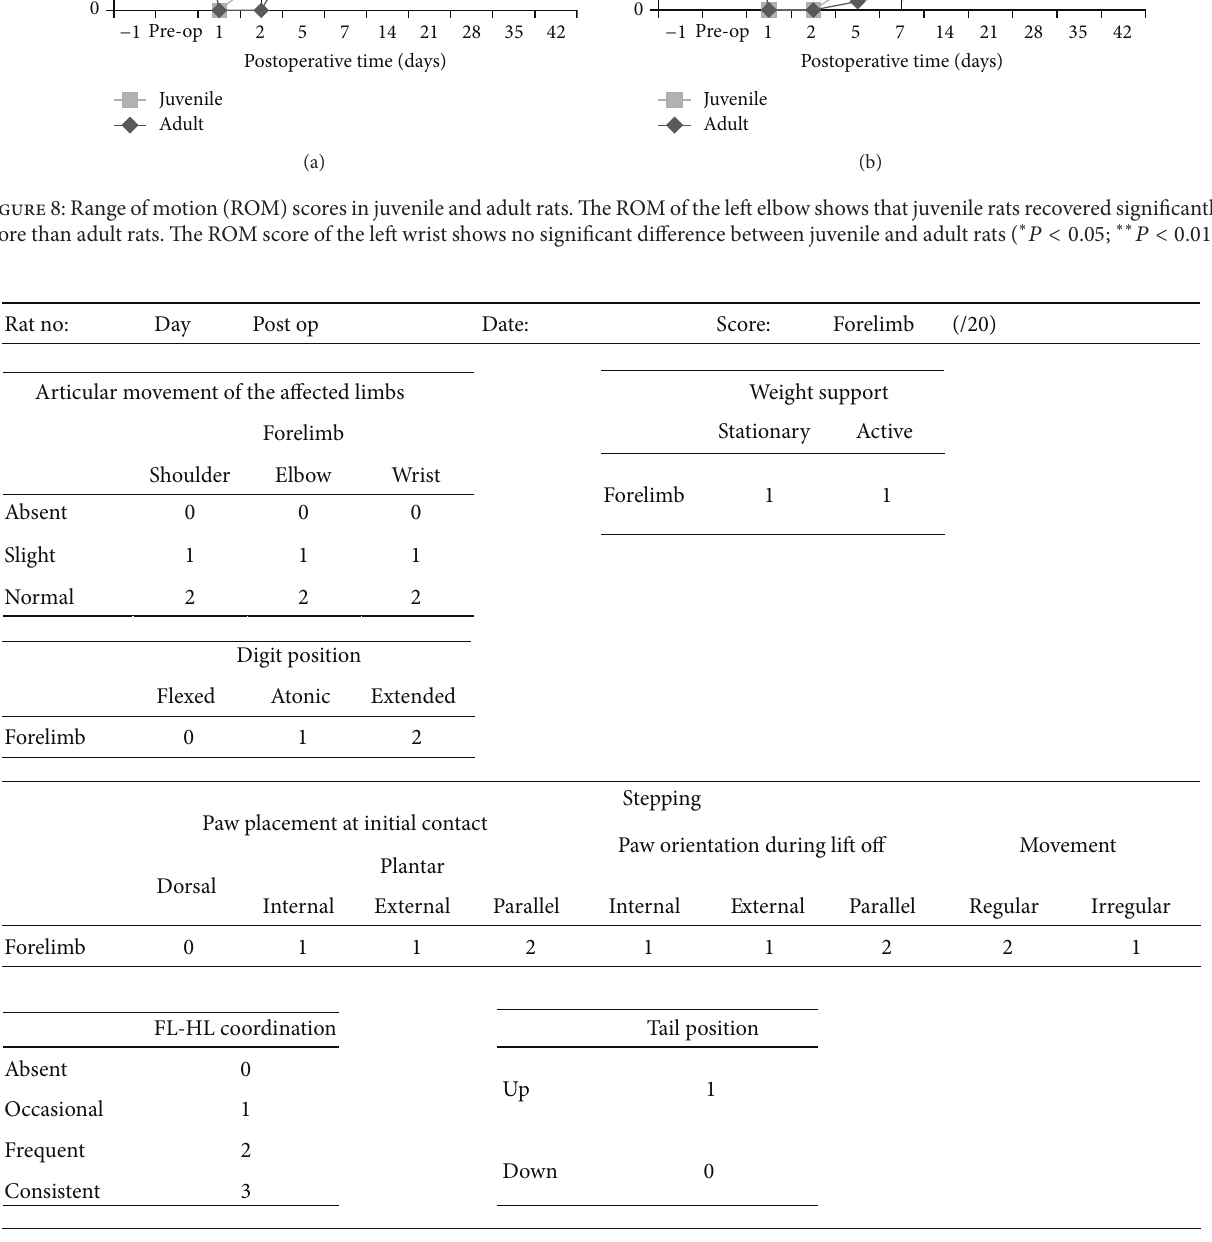
Figure 9: New Rating Scale: methods of scoring sheet (FL-HL, forelimb-hindlimb). (1) Range of motion of the shoulder, elbow, and wrist; (2) weight support of the forelimb; (3) state of the fingers and toes; forelimb walking motion; (4) stepping of the forelimb; (5) coordination of the forelimb-hindlimb; and (6) tail